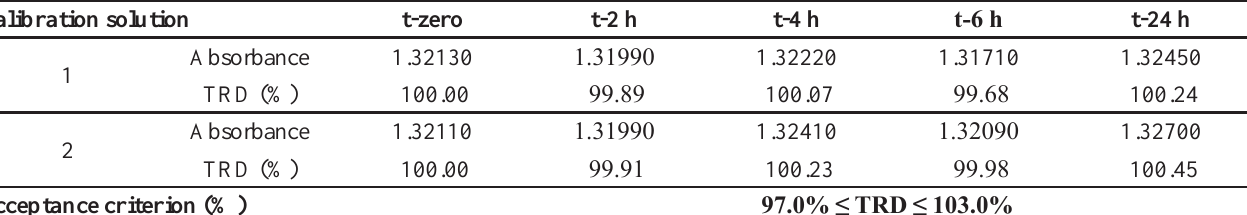
TABLE X - Results of the stability of the calibration solutions ( l = 480 nm) Calibration